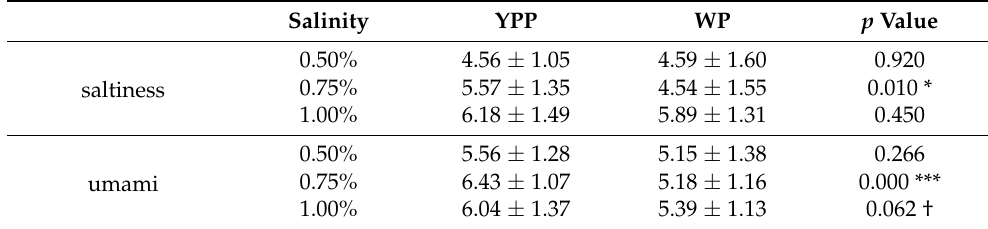
Table 1. Sensory evaluation results of pasta